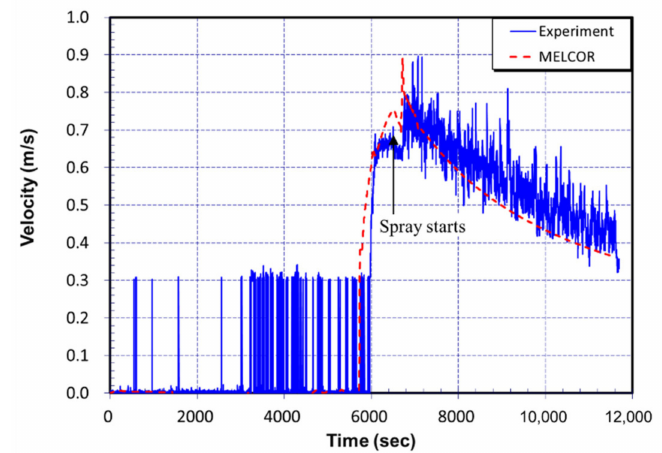
Figure 11. Comparison of PAR inlet flow between SSP1 test data and MELCOR